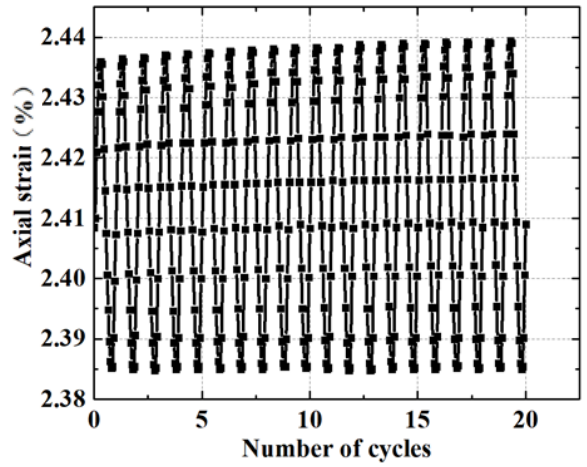
Figure 4. Axial strain of the first 20 cycles.